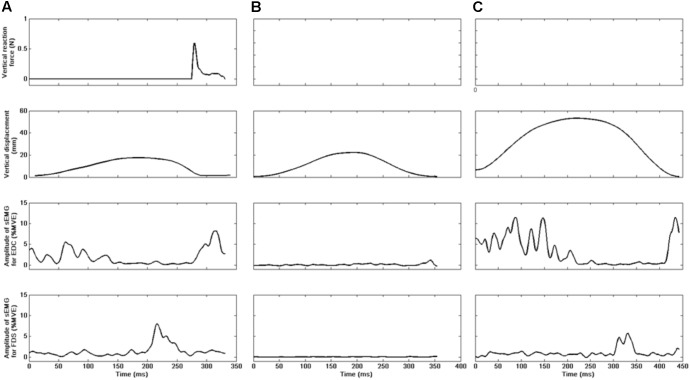
Representative recordings of individual taps in Experiment 1 from a single participant. Signals: tapping force (N), index displacement in the vertical direction (mm), as well as amplitudes of muscle activation (%MVE) for the extensor digitorum communis (EDC) and flexor digitorum superficialis (FDS) muscles. Panels (A–C) represent freely chosen tapping, passive tapping, and air tapping, respectively. Vertical displacement during air tapping (C) has been offset-adjusted. Each cycle was initiated when the tip of the finger was at its lowest point during each tap.